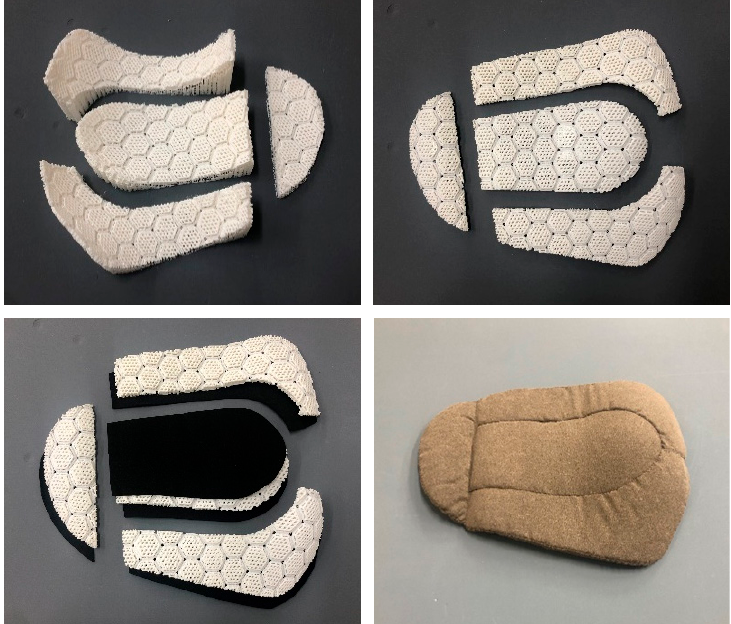
Figure 5. Composition of a 3D-printed curved pad.